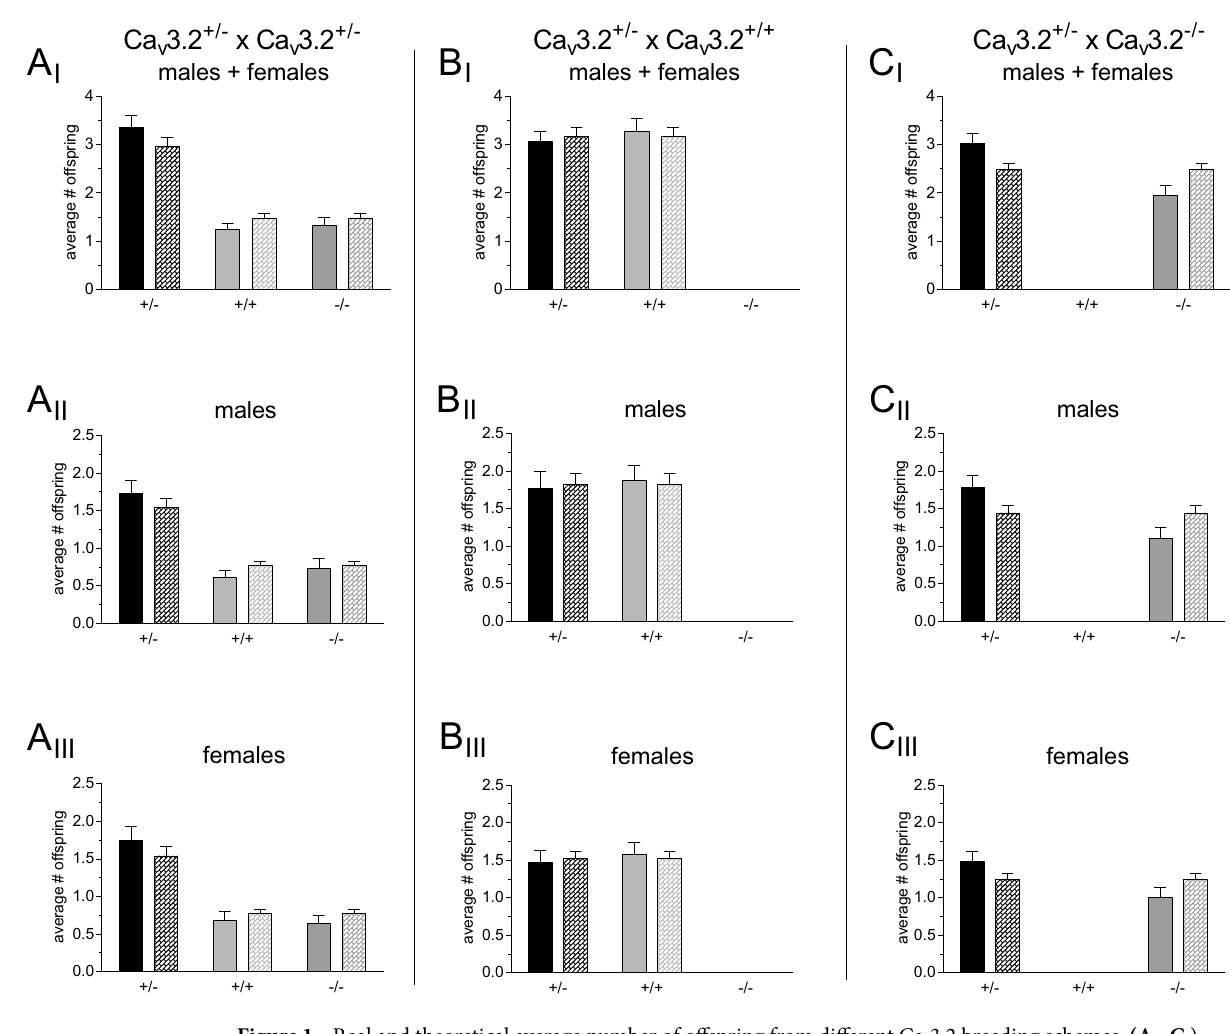
Figure 1. Real and theoretical average number of offspring from different Ca v 3.2 breeding schemes. (A I –C I ) Breeding results for both sexes using a Ca v 3.2 +/− × Ca v 3.2 +/− , Ca v 3.2 +/− × Ca v 3.2 +/+ and Ca v 3.2 +/− × Ca v 3.2 −/− breeding scheme. In addition, these data were analyzed separately for male offspring ( A II –C II ) and female offspring ( A III –C III ). Plain bars indicate real average offspring number, patterned bars indicate the theoretical average offspring number based on the Mendelian inheritance.